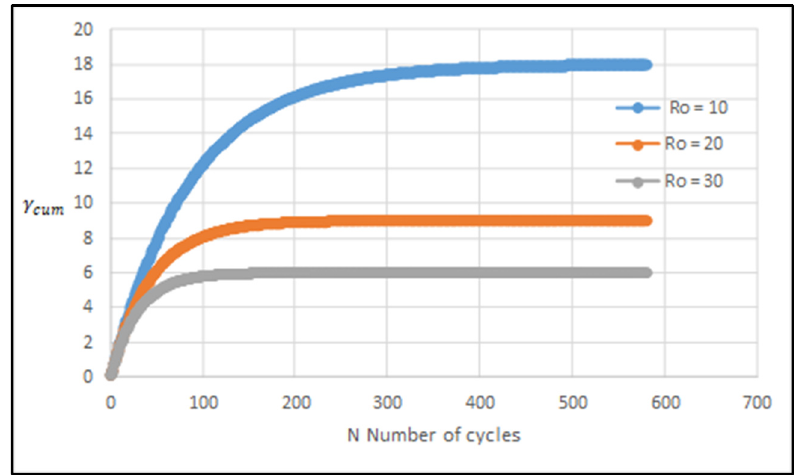
Figure 8. Effect of isotropic hardening (R o parameter).